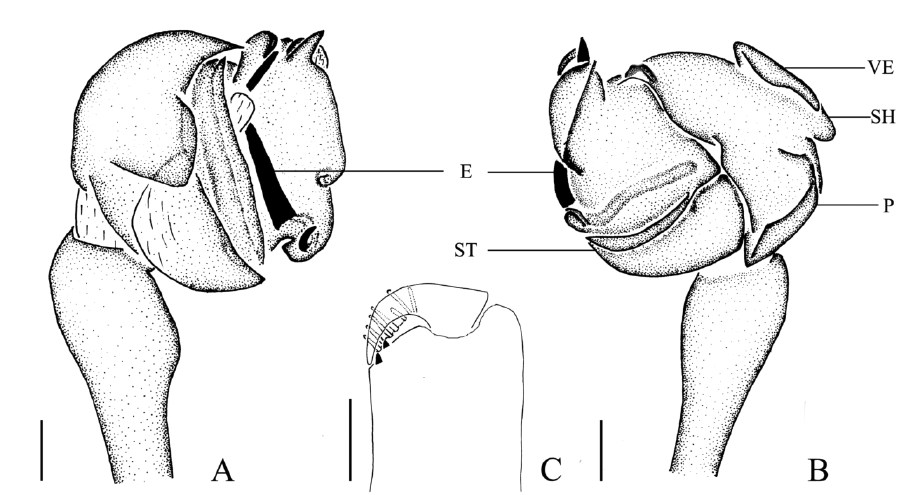
Figure 8. Mimetus wangi sp. n., holotype male. A palp, ventral view B palp, prolateral view C left chelicera, ventral view. Scale bars: A–B , 0.1; C , 0.1.